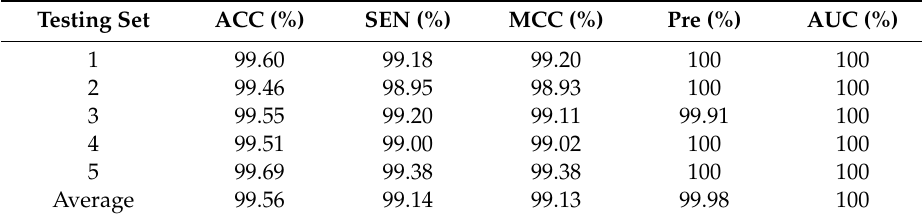
Table 3. five-fold cross-validation results on the yeast data